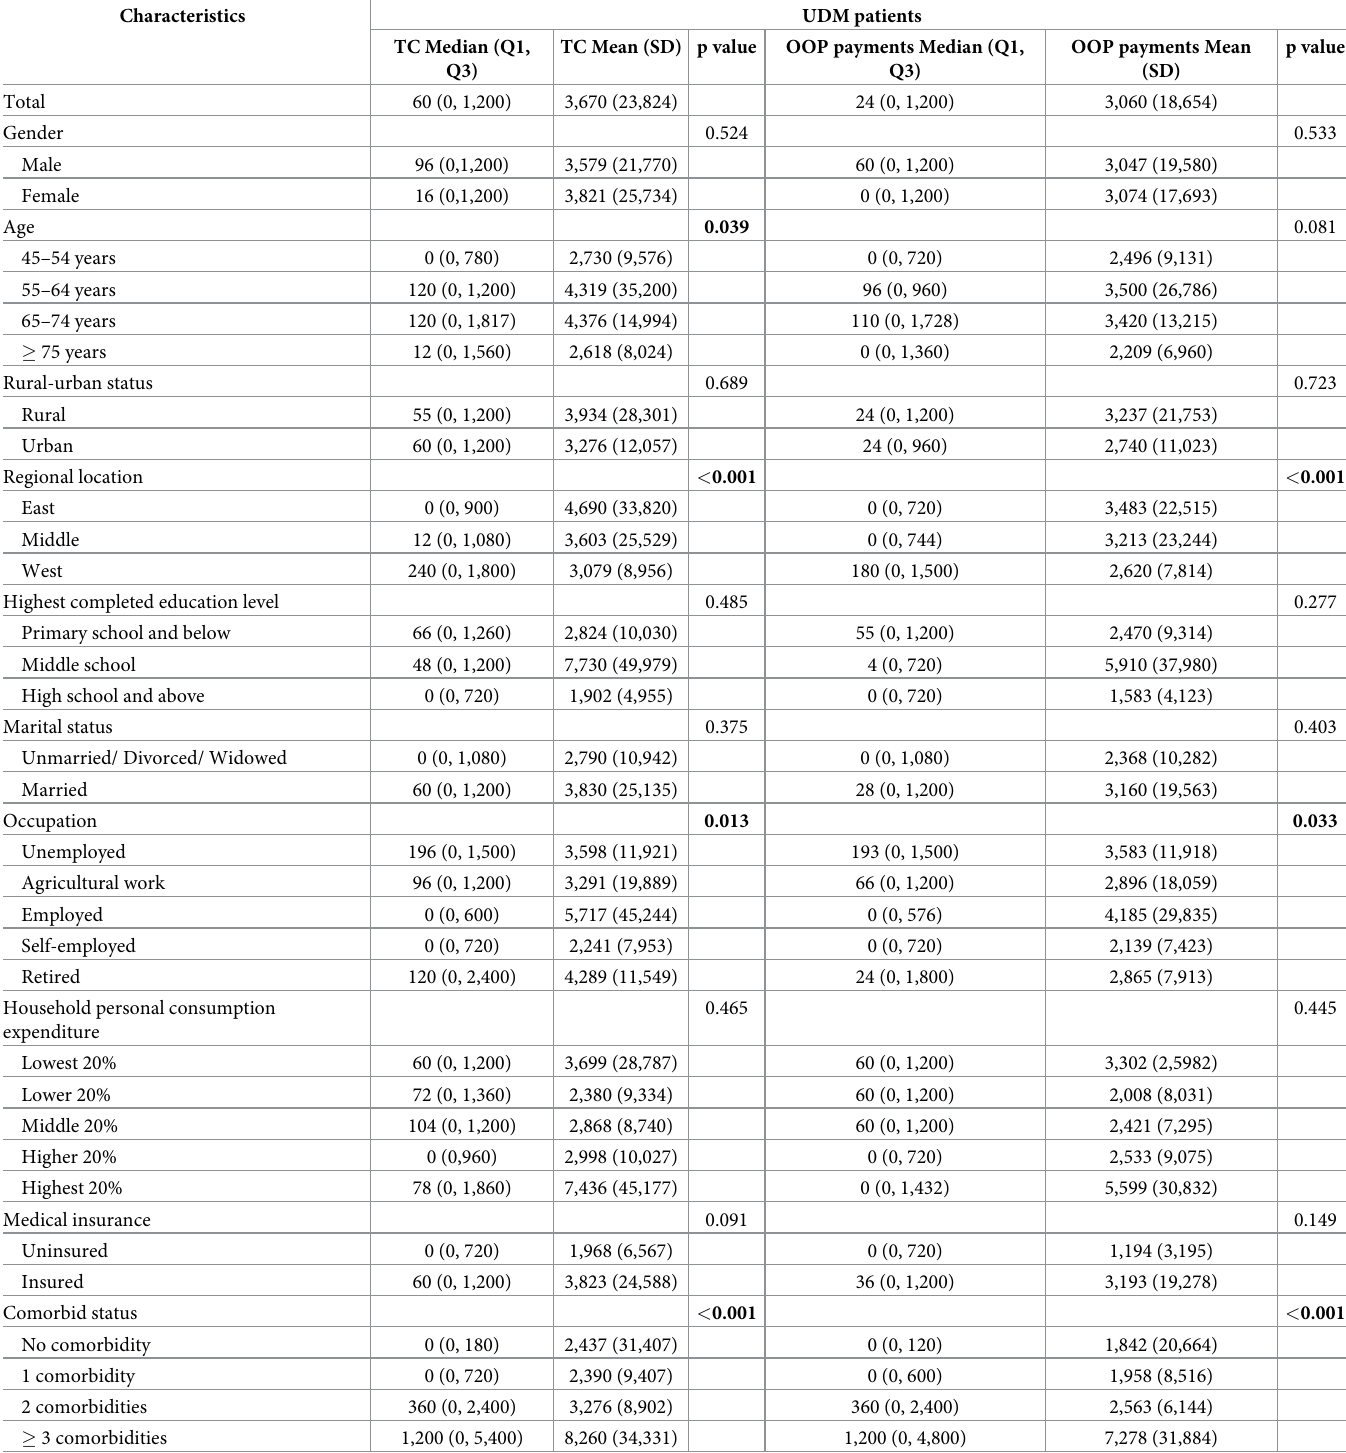
Table 3. TC and OOP payments in the population with UDM in the CHARLS 2011 study.